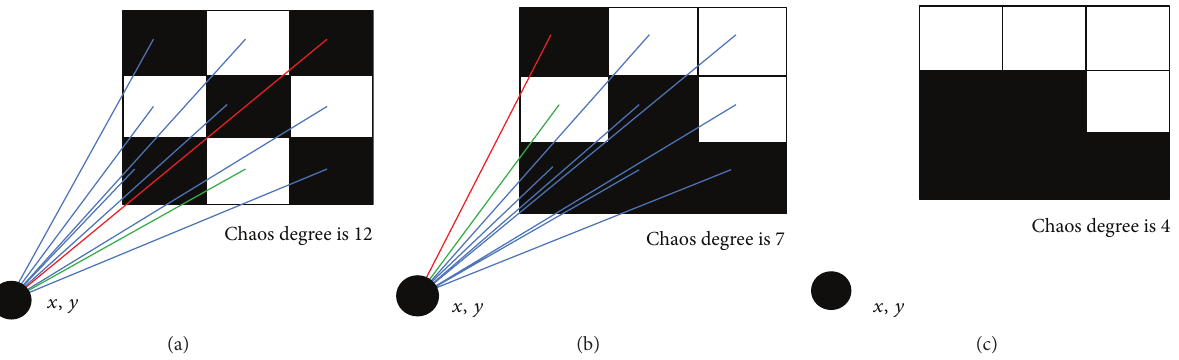
Figure 10: Denoise examples based ongravity center and chaos degree. The black point 𝑥,𝑦 is the gravity center of pattern 𝑝 󸀠 . The line denotes the distance of each pixel to 𝑥,𝑦 , in which the red line is the maximum distance of black pixel to gravity center and the blue line is the minimum distance of white pixel to gravity center: (a) the chaos degree is 12; by moving the black pixel which has the maximum distance to white pixel which has the minimum distance, we get pattern (b) whose chaos degree is 7; by moving the black pixel, we get the pattern (c) whose chaos degree is 4, less than 5.